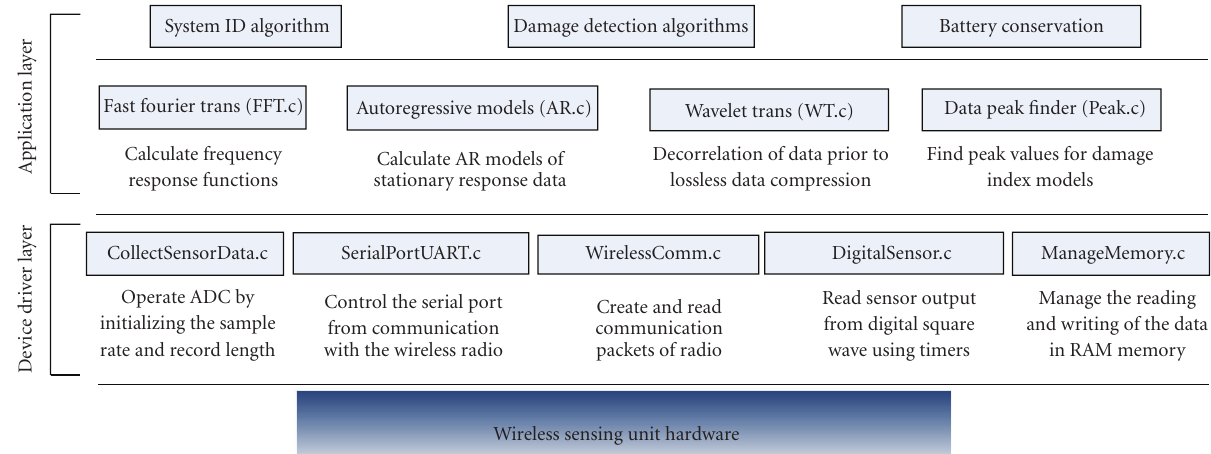
Figure 1: Hardware of the academic wireless sensing unit.